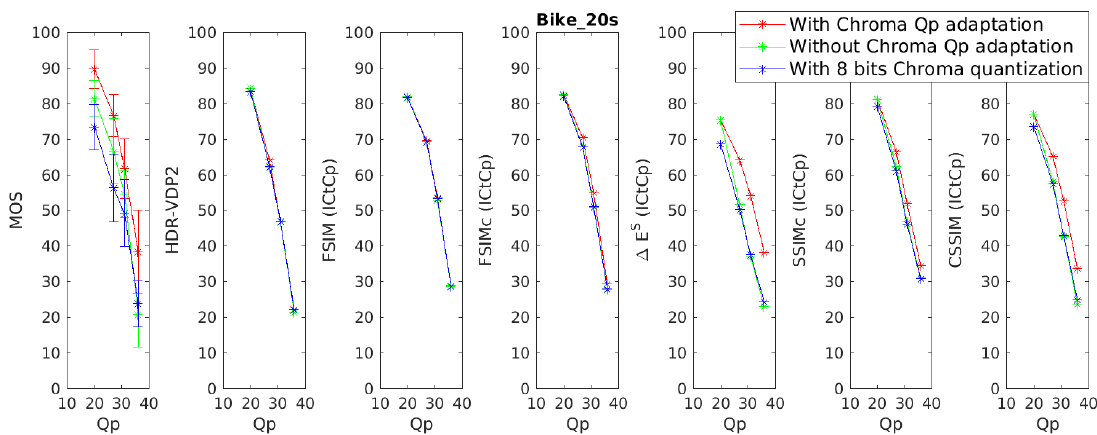
Figure A6. Subjective and objective scores for the image Bike_20s.